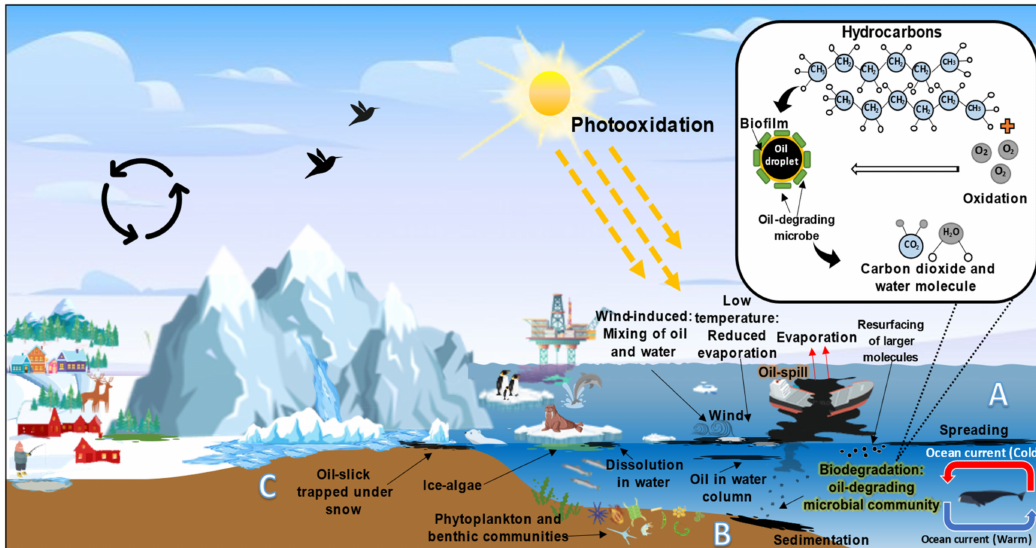
Figure 7. The fate of oil spills into the Arctic marine environment from the aspects of the ( A ) seawater, ( B ) marine sediment, and ( C ) coastal environments (Adapted from: